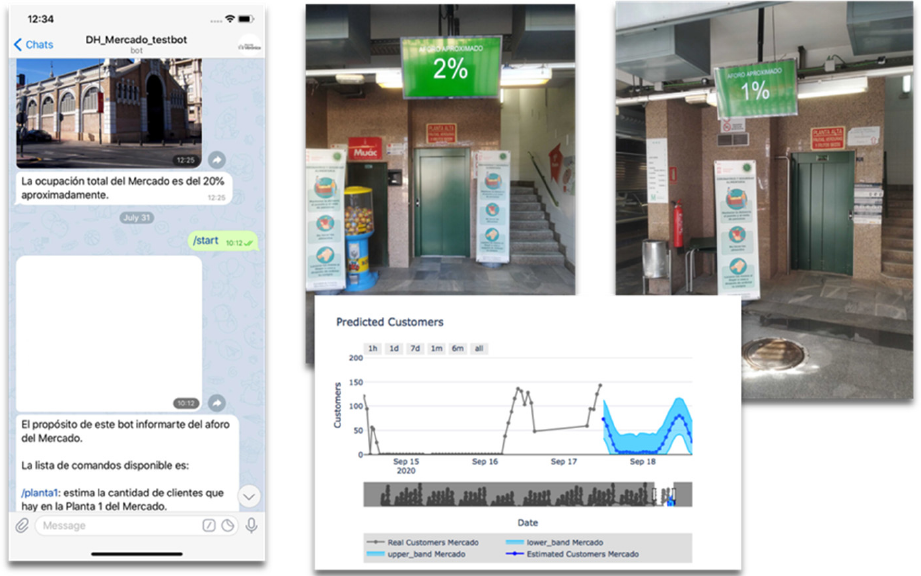
Figure 7. Example of the results obtained in the real indoor deployment; Left: example of the instructions and information shown through the Telegram bot (active warning); Right: physical screens to warn clients about the current capacity at different times, limiting if necessary the entrance to the monitored space; Lower: forecasting the number of clients for the next 24 h.